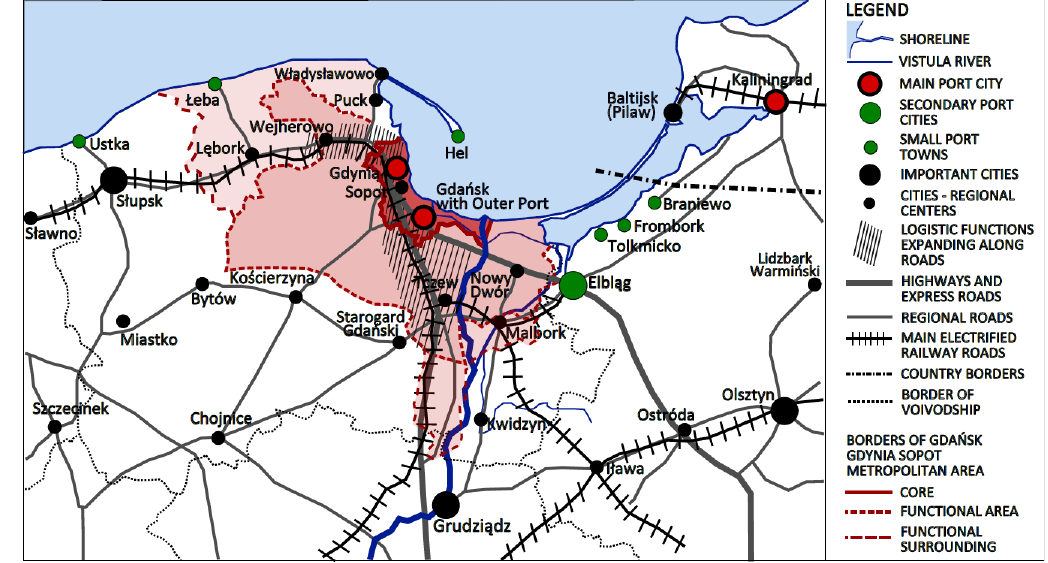
Figure 8. Contemporary Gdańsk Bay port region geography. redefinition of the porous structure of the Gdańsk Bay port region and its dual character based on differences between deep‐water cargo‐handling infrastructure and leisure‐oriented seaside